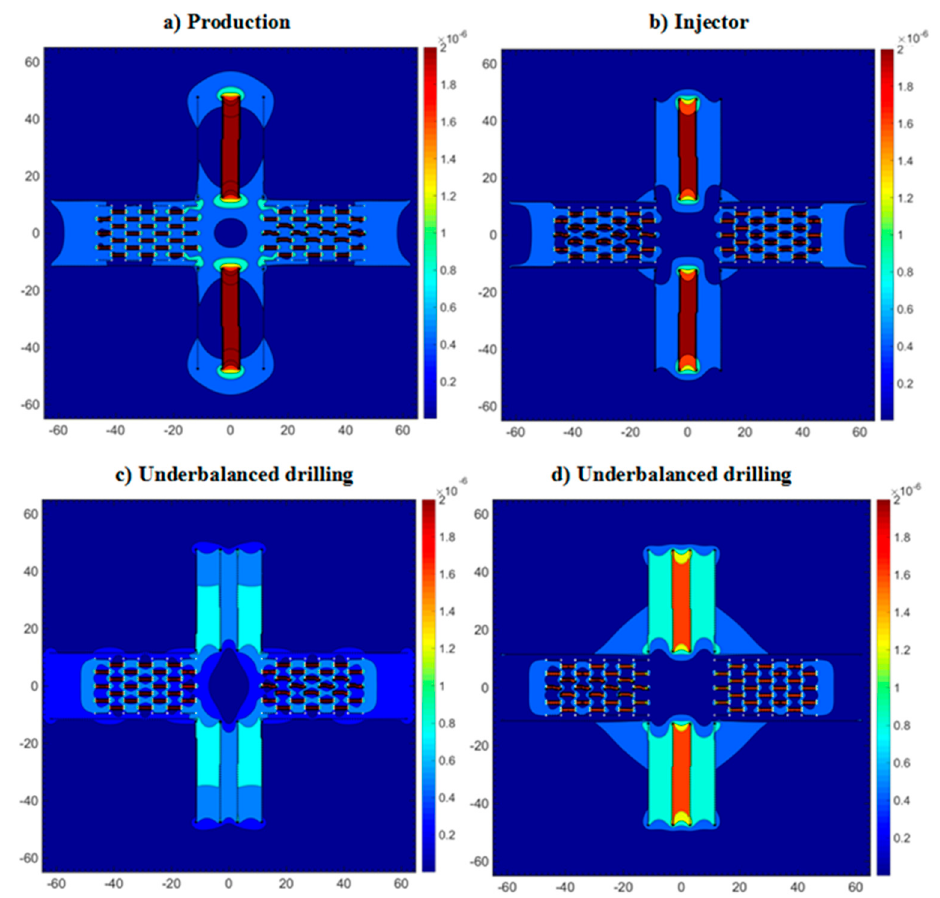
Figure 20. Absolute velocity magnitude (scaled in cm s − 1 ) for flow fields in Figures 8–11. Largest velocities occur in pore throats and in wellbore section. Length units are scaled in cm (both x-axis and y-axis).